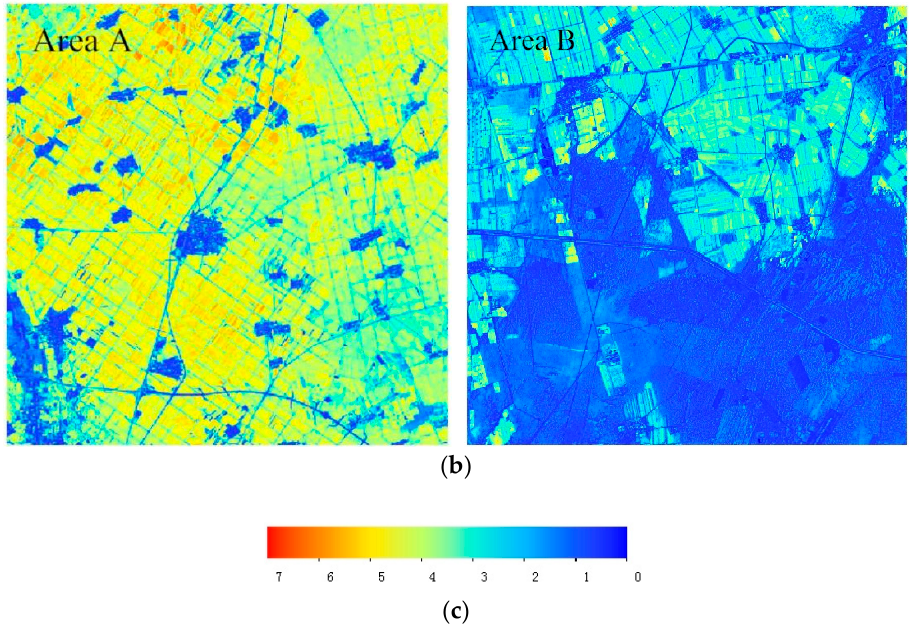
Figure 2. Comparison of Sentinel-2A Leaf Area Index (LAI) data and inversed LAI from Landsat 8 Operational Land Imager (OLI) data. ( a ) LAI retrieved by support vector regression (SVR) model on 2 August 2018; ( b ) LAI product of Sentinel-2A on 1 August 2018; ( c ) the legend of the maps.3.4. Estimation of LAI Using the Improved FSDAF Model.